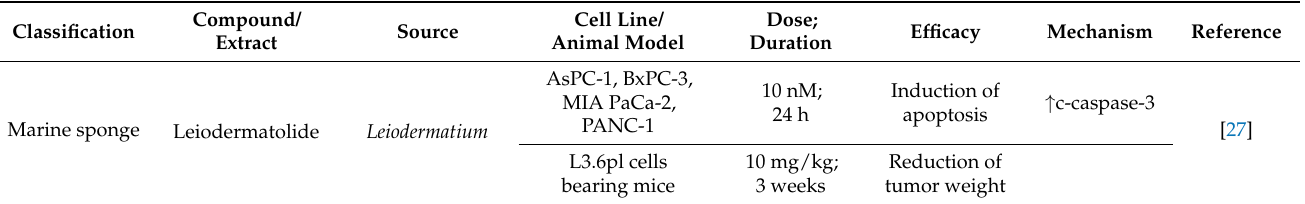
Table 2. Apoptosis inducing marine